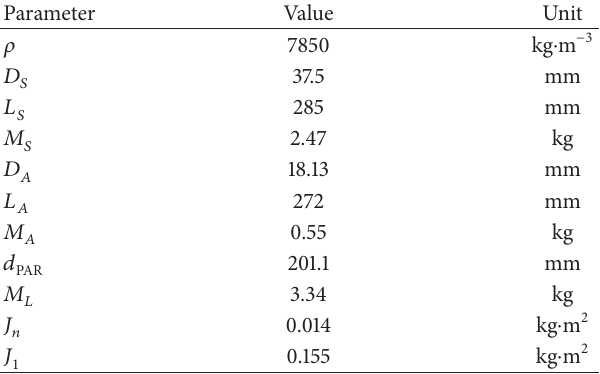
Table 2: Mechanical parameters of actuator used for moment of inertia calculation. In the table, 𝜌 is steel density, 𝐽 𝑛 is calculated moment of inertia for no load, and 𝑀 𝐿 is load weight (all other variables as described in Figure